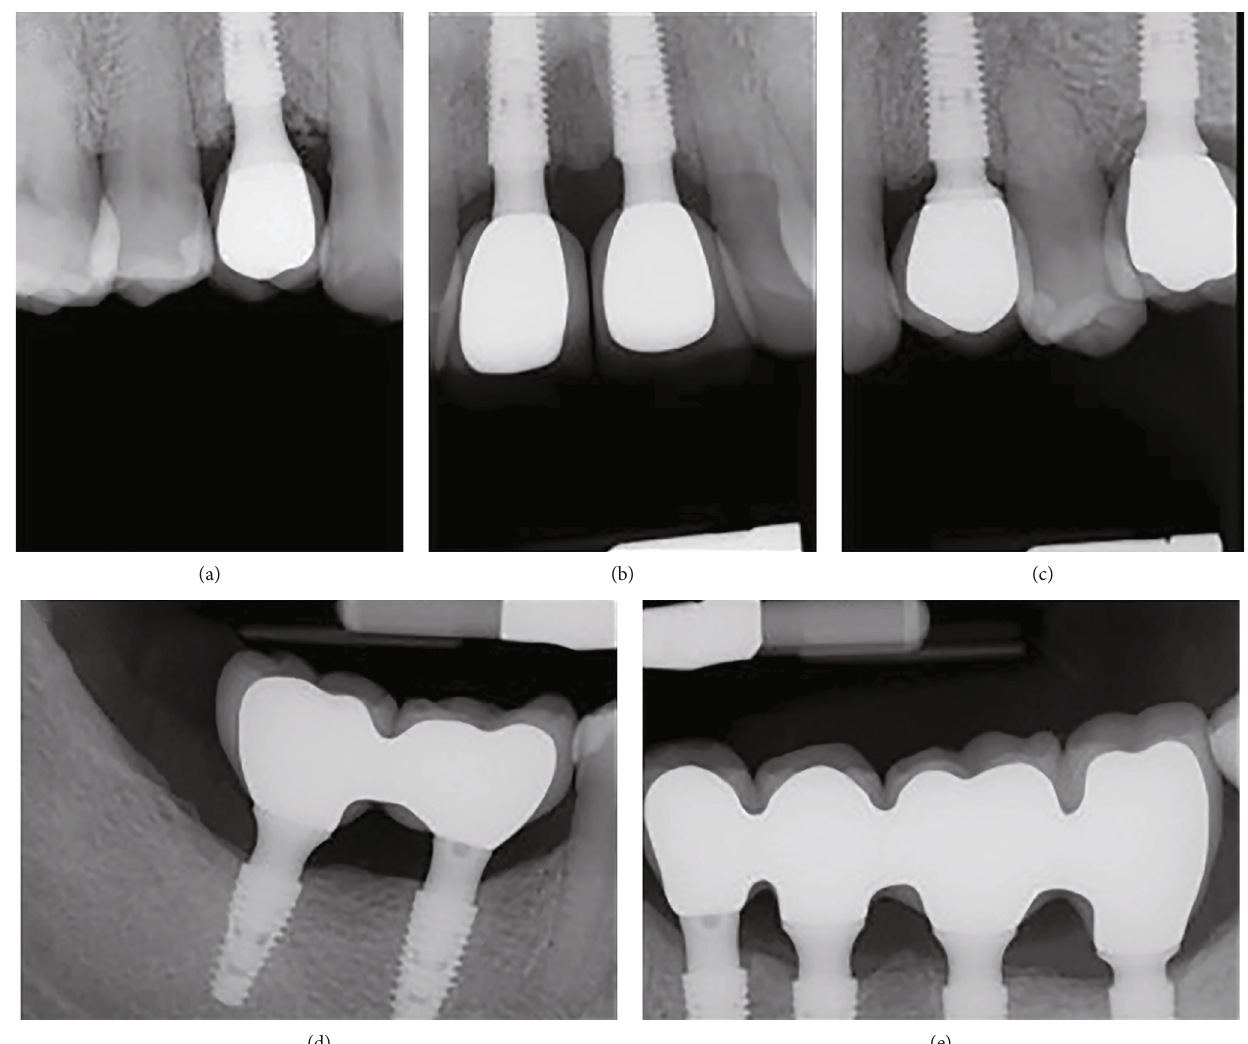
Figure 8: Periapical X-rays of maxillary (a) – (c) and mandibular (e, e) implants at the 24 months follow-up